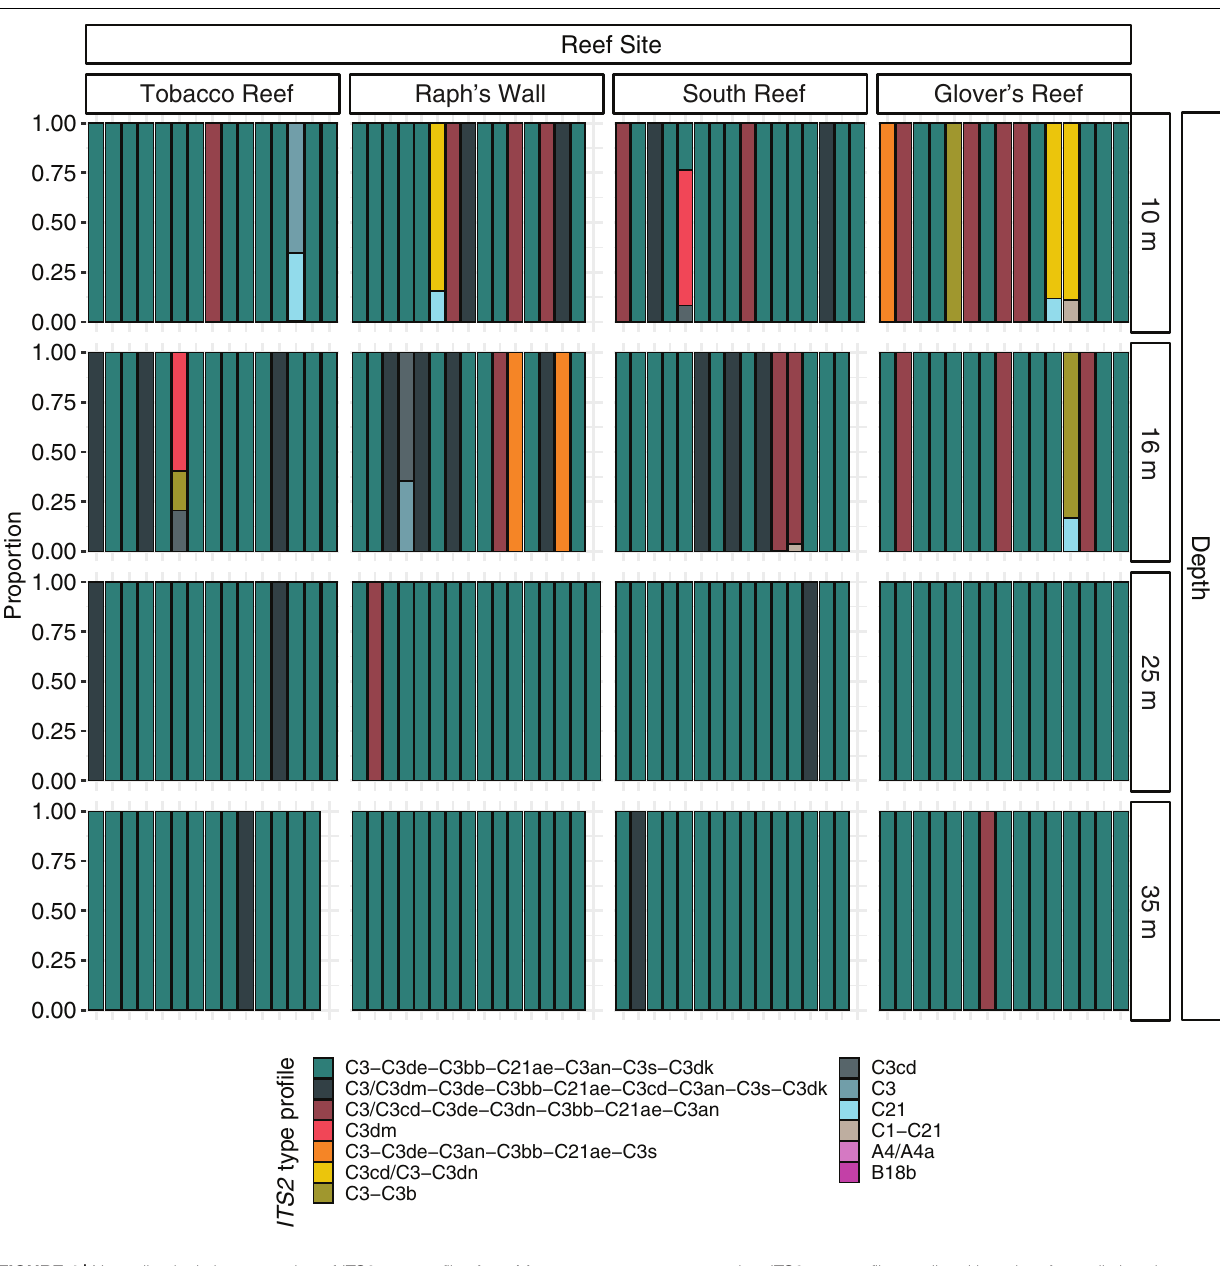
FIGURE 4 | Normalized relative proportion of ITS2 type profiles from Montastraea cavernosa samples. ITS2 type profiles are listed in order of overall abundance. ITS2 type profiles are named for the defining intragenomic variants (DIVs) used to characterize them. DIVs in a type profile name are listed in order of abundance with ‘/’ separating DIVs with co-dominance in